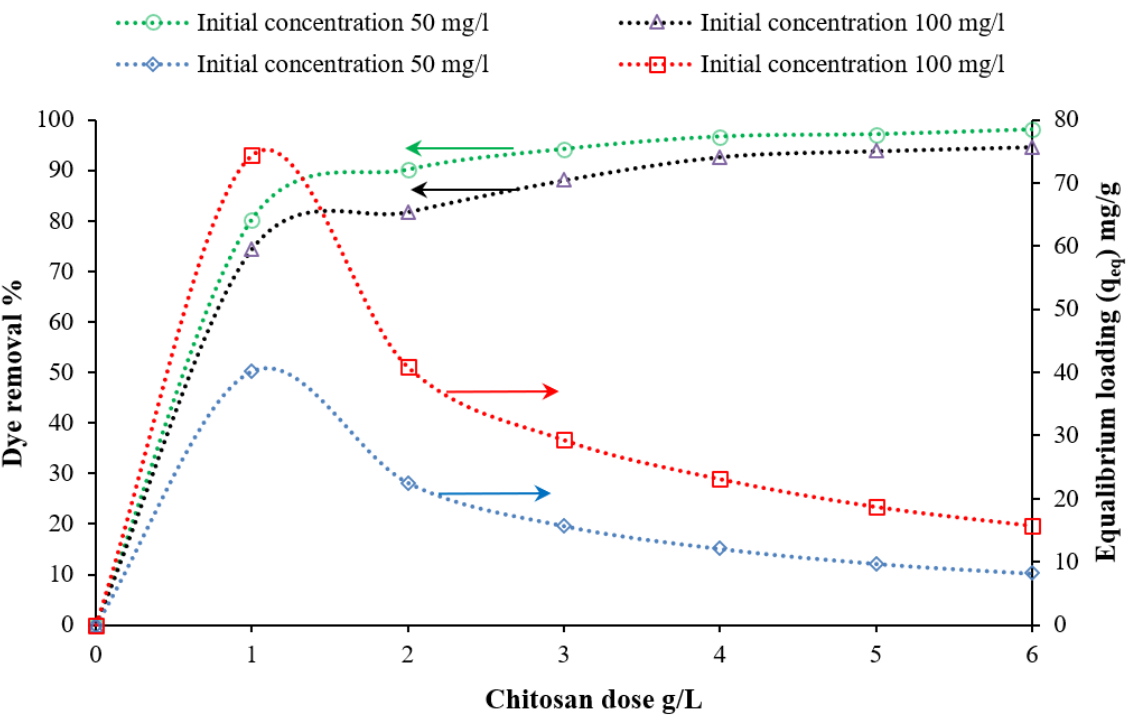
Figure 10. Effect of chitosan concentration on DB78 dye removal efficiency (temperature of 22 °C, pH of 8.5, mixing speed of 150 r.p.m., and contact time of 45 min). For nanocellulose, it was observed that a removal percentage of 93.2% and equilibrium loading of 46.6 mg/g can be obtained by using a nanocellulose dose of 2 g/L for solutions with an initial concentration of 100 mg/L, as shown in Figure 11. The maximum equilibrium loading reached was 239